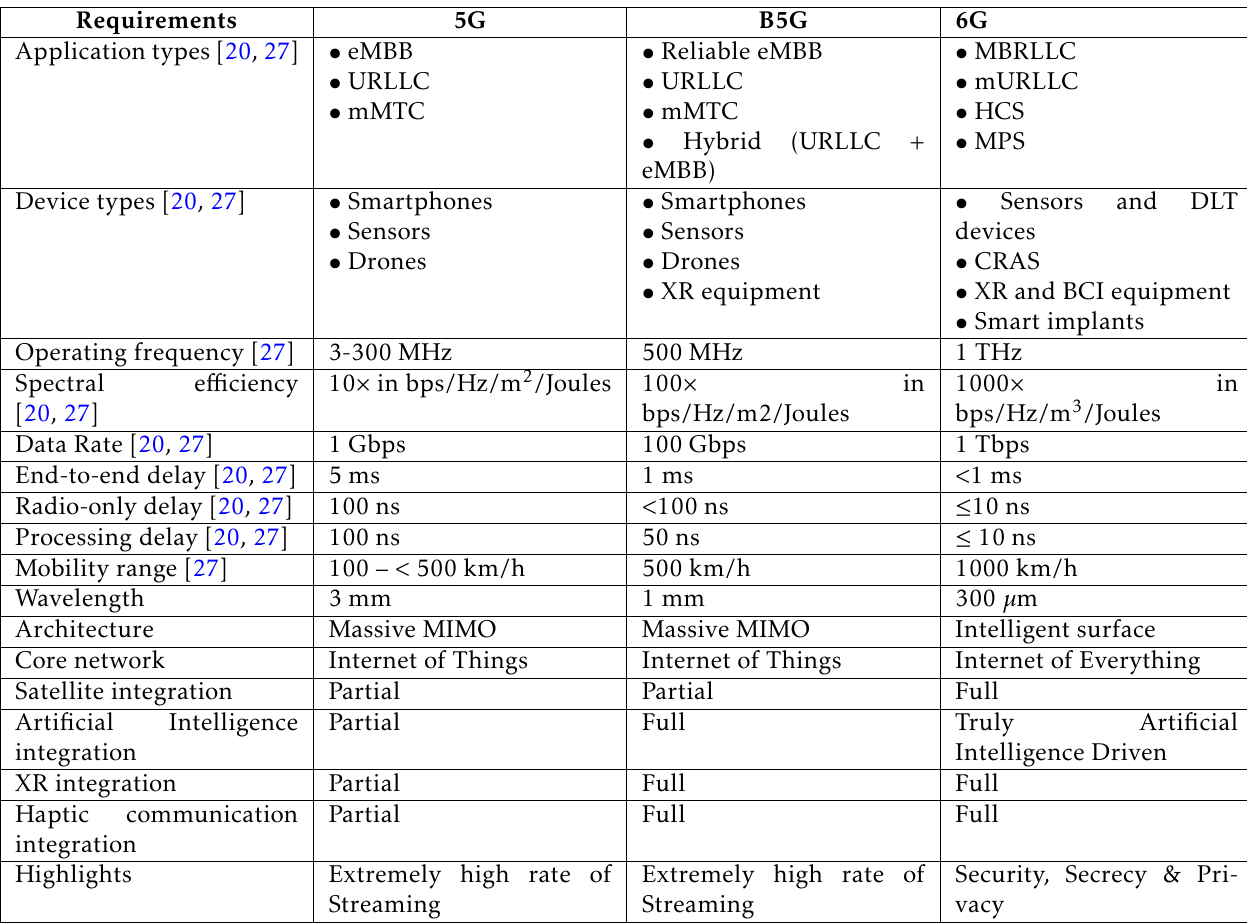
Table 1. Comparison among 5G, B5G and 6G